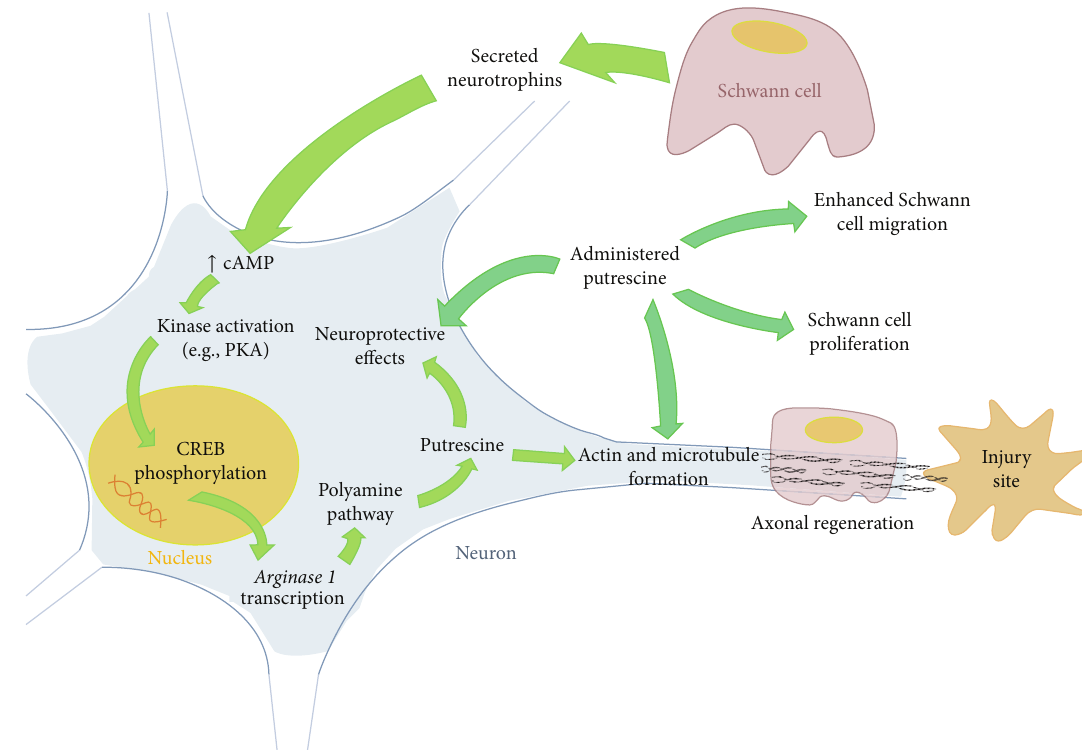
Figure 1: The role of putrescine in neuron and Schwann cell responses. This figure summarizes the previously reported functions of polyamines in neurons and Schwann cells within the wider literature from in vitro and in vivo studies and how these mechanisms could elicit the observed responses in the current study. Neurotrophins and growth factors secreted by implanted Schwann can elevate intrinsic cyclic AMP levels within neurons. Cyclic AMP is an important second messenger whose main effectors are downstream protein kinase signaling cascades (e.g., PKA) that result in the phosphorylation and activation of the constitutive transcription factor CREB. Bound to the nuclear DNA, CREB is known to enhance the expression of a number of genes that include arginase 1 , which encodes the first enzyme of the polyamine pathway to generate endogenous putrescine. Putrescine produces a number of neuroprotective effects by scavenging free radicals and suppressing excitotoxicity. Putrescine also promotes the reorganization of actin and microtubules, allowing axons to grow. Administered putrescine is known to be taken up by both the neuron, bolstering the effects of the endogenous polyamines, and SCs, encouraging their migration and proliferation in vitro . We hypothesize that SC implants and administered putrescine work in concert to augment each other’s ability to promote neuropreservation and neuroregeneration following